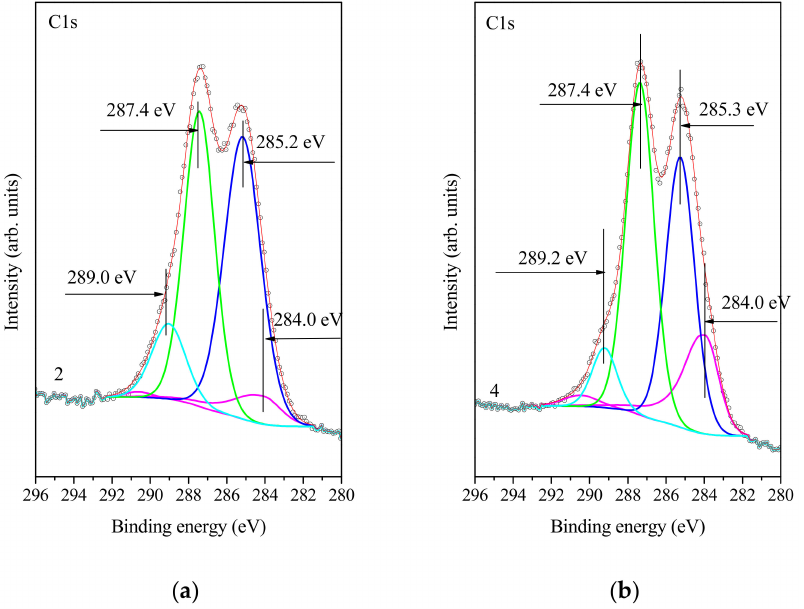
Figure 2. ( a ) XPS measurement of TGO, (284.0 eV C=C; 284.4 eV C-O; 289.0 eV C=O; ( b ) XPS of HGO, (284.0 eV C=C; 285.3 eV C-O; 287.4 eV C=O and 289.2 eV O-C=O).